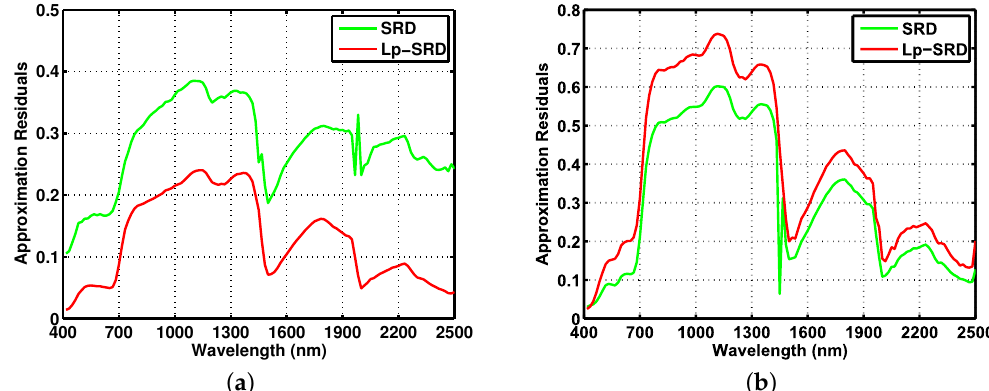
Figure 3. Comparison of l p -norm and l 1 -norm target-based representation residuals of a target pixel (yellow nylon) and a background pixel (mixture of grass and building) in the HyMap data. It is desired that the target pixel has a small residual, and the background pixel has a large residual. ( a ) Target pixel. ( b ) Background